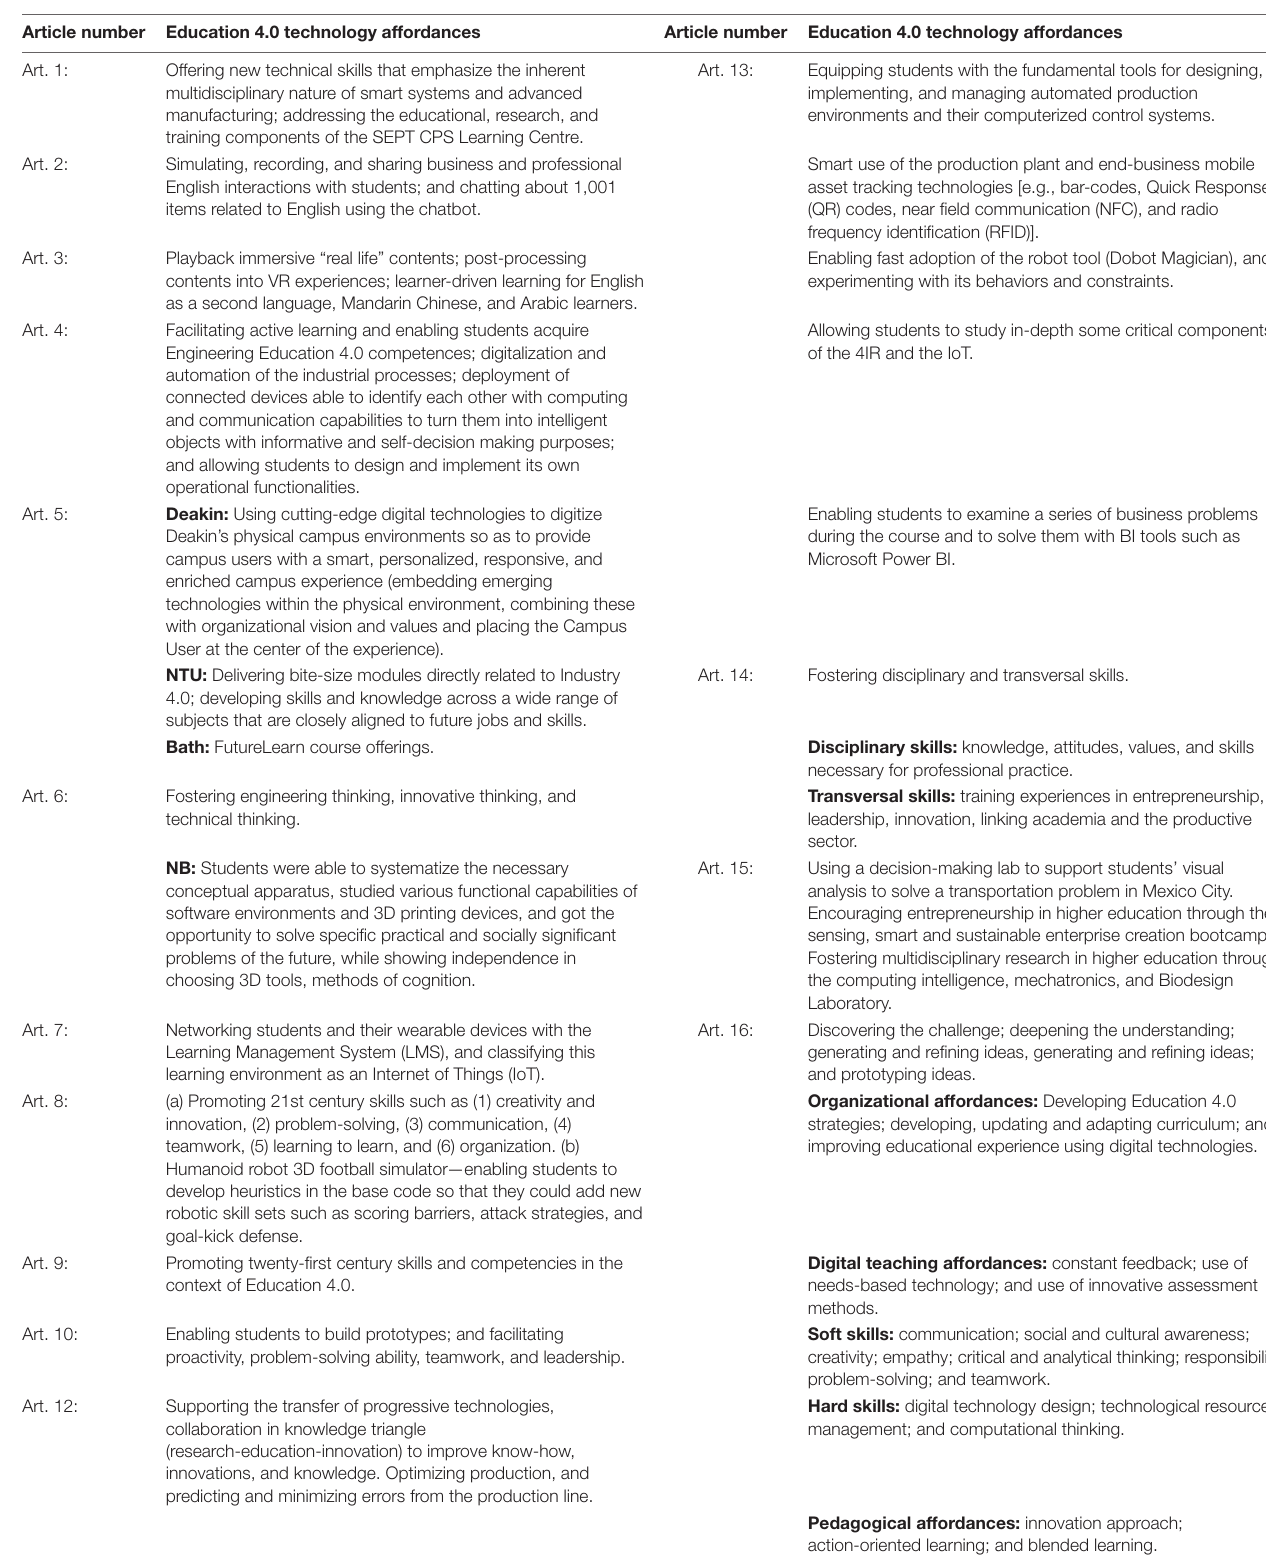
TABLE 2 | Articles and the affordances offered by their Education 4.0